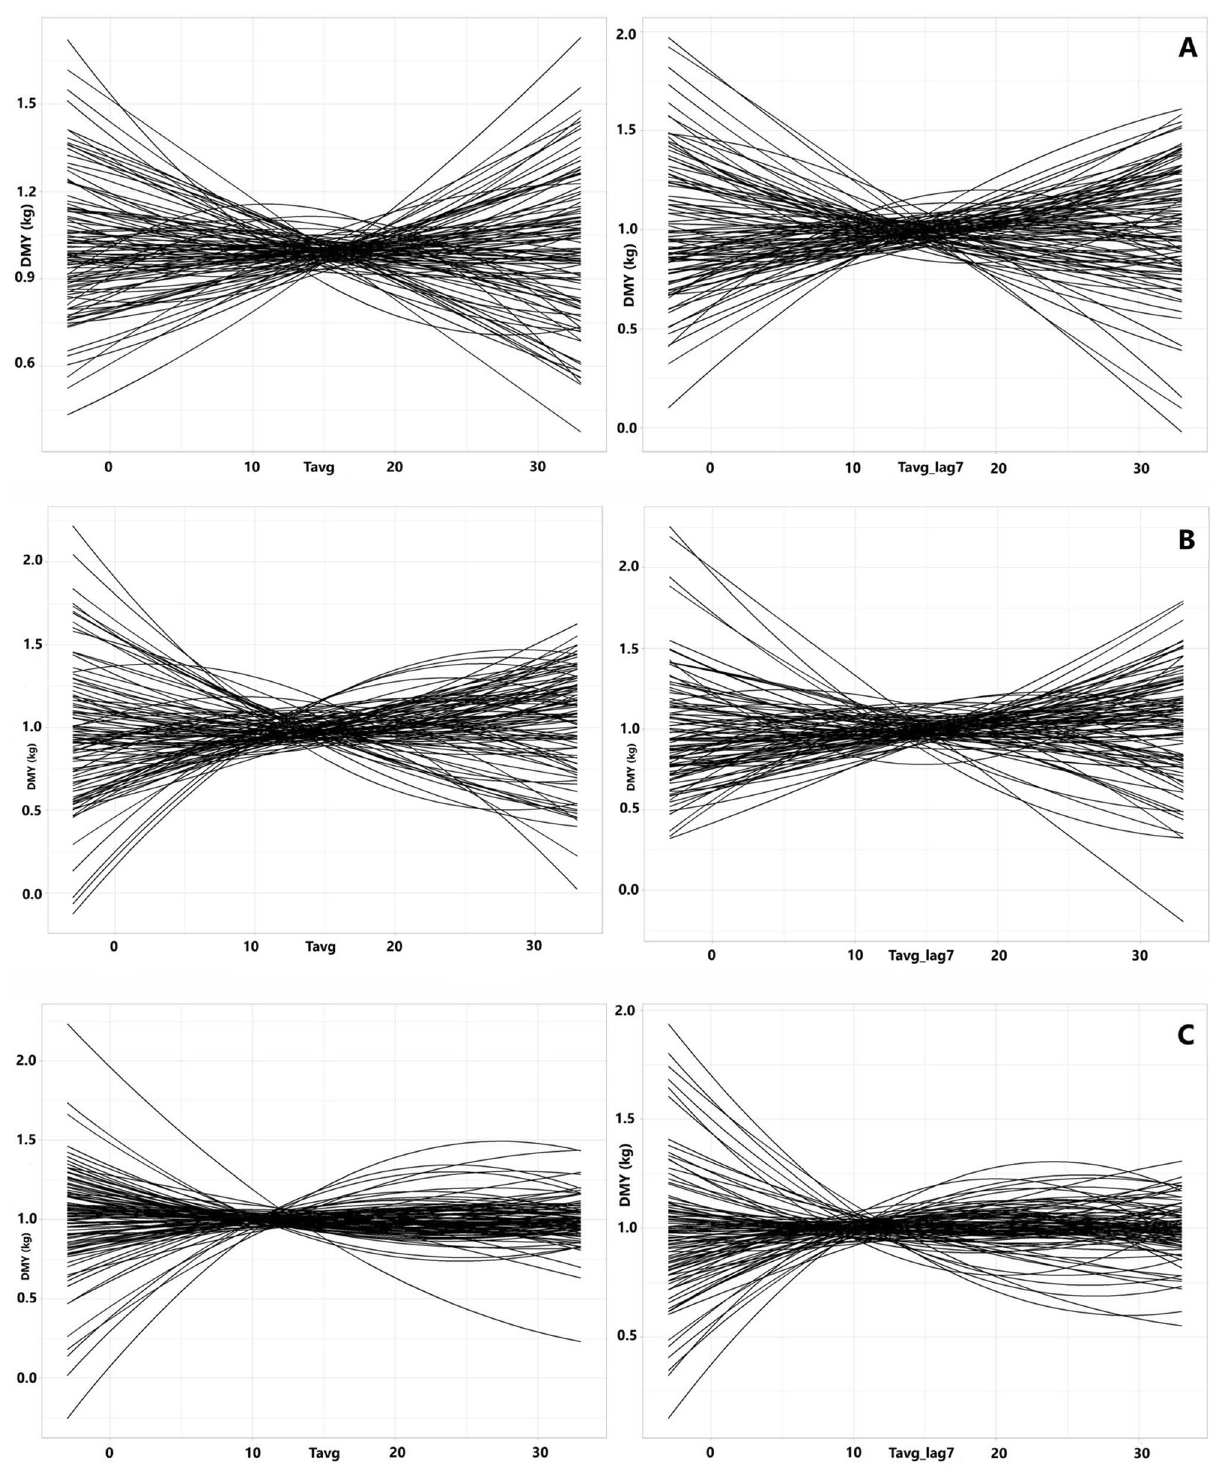
Figure 2. Individual animal reaction norms by lambing season (n = 100). Each curve represents the individual animal changes in daily milk yield (DMY, kg) in response to average air temperature variation on the milk test date (Tavg, °C) and week average air temperature preceding the milk test date (Tavg_lag7, °C), respectively. A: autumn lambing, B: winter lambing, C: spring